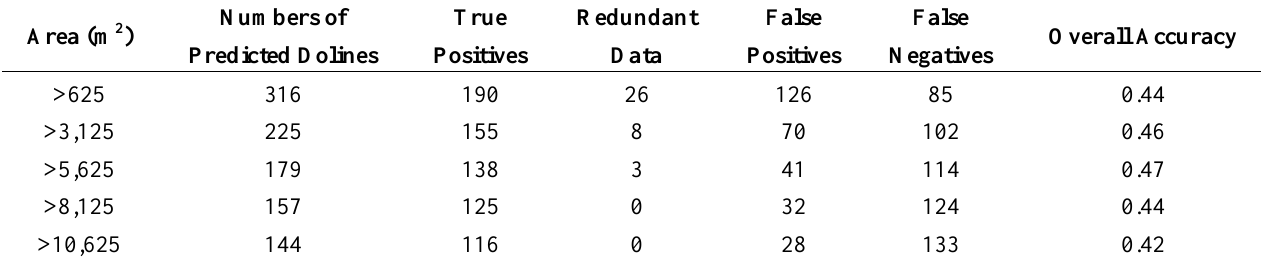
Table 7. Predicted dolines using area attribute from dolines depth > 3 m (ALOS/PRISM-DEM). The comparison is made with true dolines (249) obtained by visual interpretation.